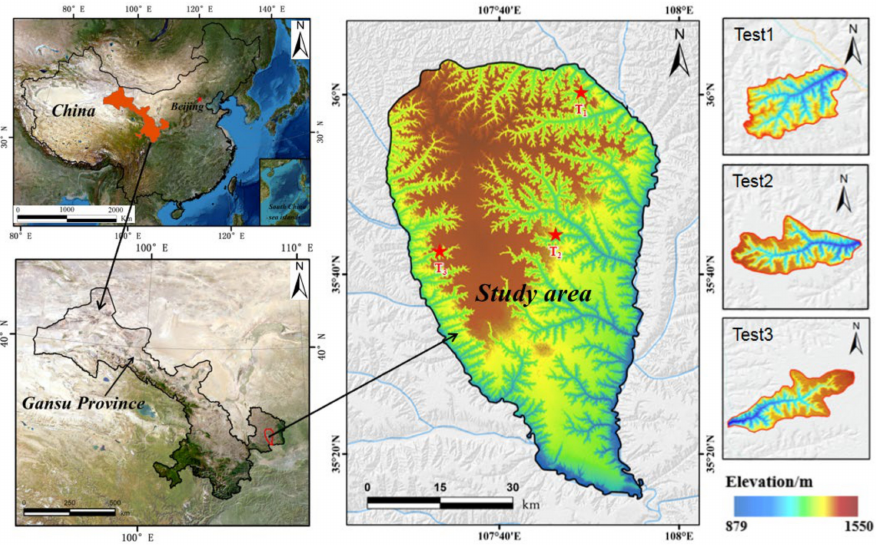
Figure 1. Location of the study area in Qingyang, Gansu Province, China, and the three test